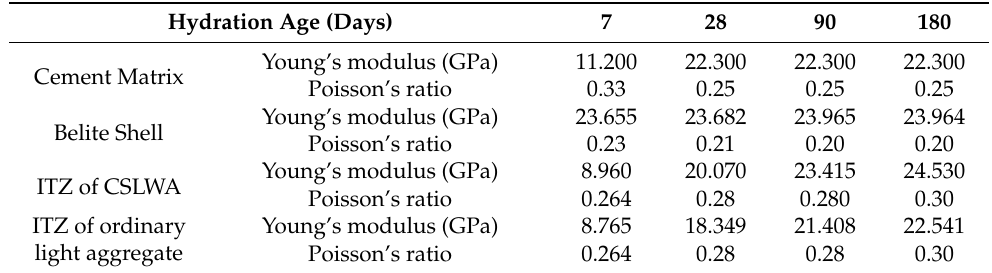
Table 3. Material parameters of shell and cement matrix at different hydration ages (W/C =